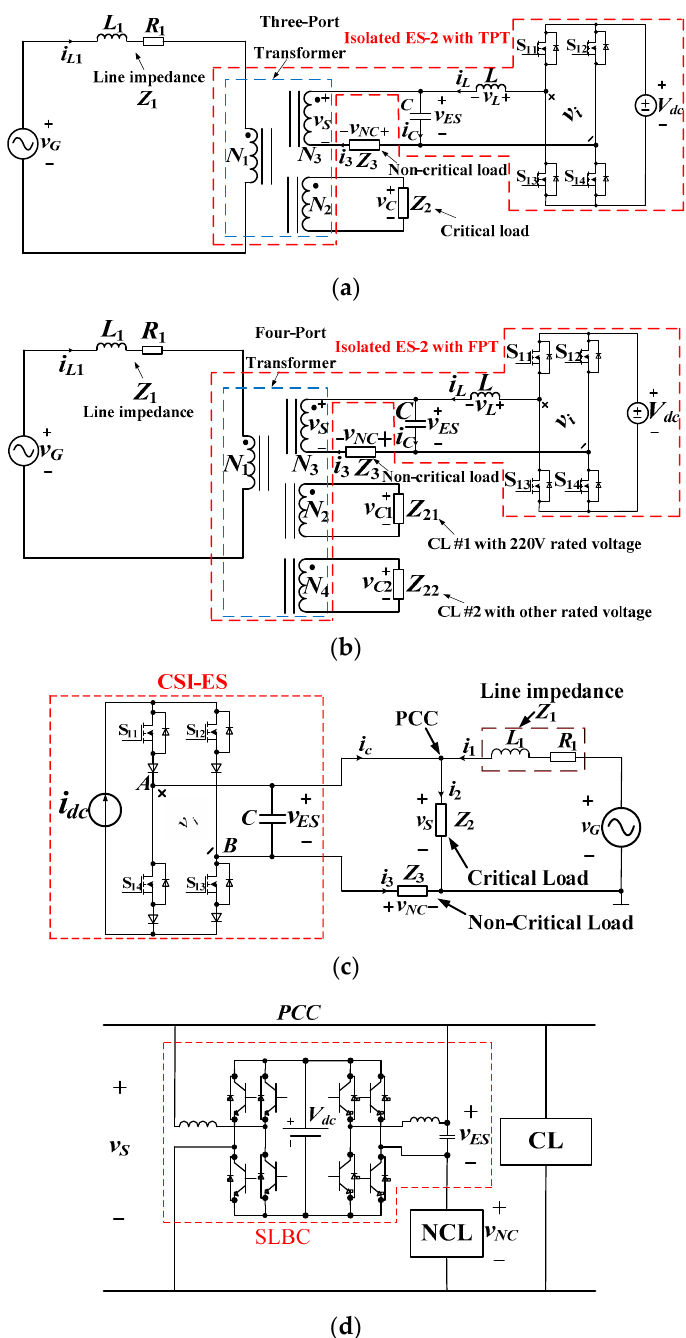
Figure 7. Other ES topologies and their typical application circuits. ( a ) Isolated ES-2 with three-port transformer (TPT); ( b ) Isolated ES-2 with four-port transformer (FPT); ( c ) CSI-ES and its typical application circuit; ( d ) SLBC and its typical application circuit.